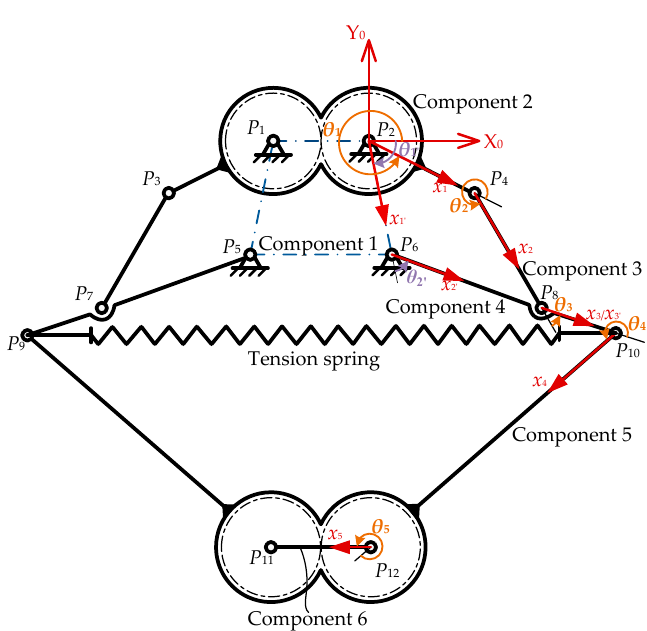
Figure 6. The kinematics model of the hopping mechanism. Where component 1 is the frame P 1 P 5 P 6 P 2 ; component 2 is the crank–gear–bar P 2 P 4 ; component 3 is the connecting rod P 4 P 8 ; component 4 is the rocker P 6 P 8 P 10 ; component 5 is the gear-bar P 10 P 12 ; component 6 is the connecting rod P 12 P 11 that is connected with the rotation center of the gear–bar.